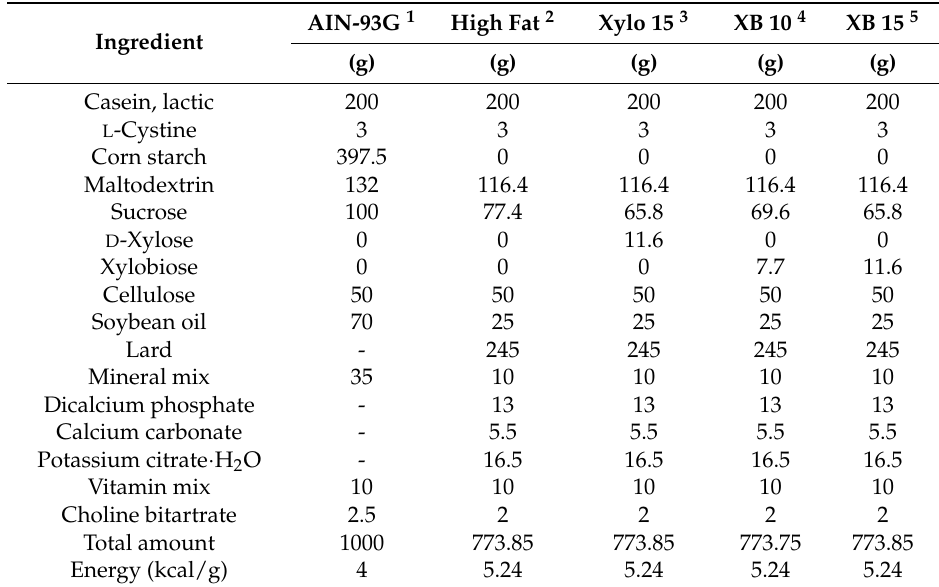
Table 3. Compositions of the diets used in the